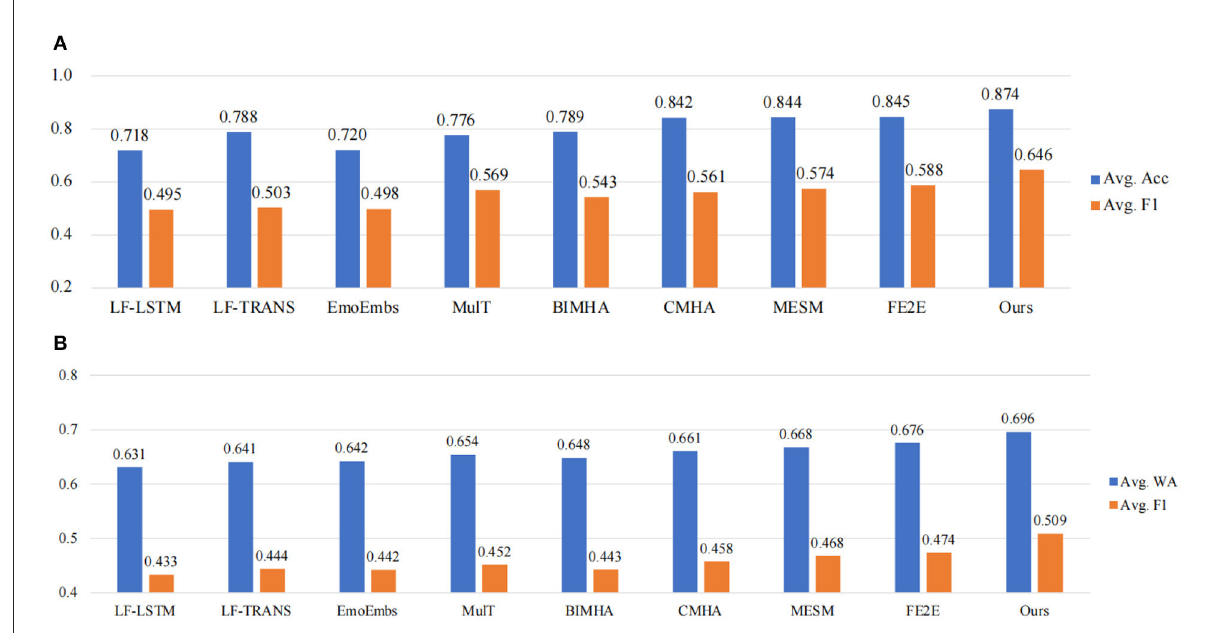
FIGURE4 Comparison with state-of-the-art methods on two benchmark datasets. (A) Comparison results on IEMOCAP. (B) Comparison results on